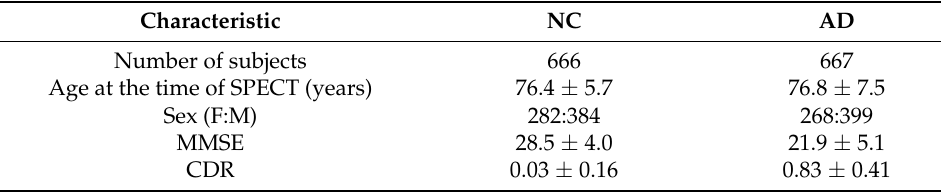
Table 2. Demographic and clinical characteristics of F-18-FDG PET